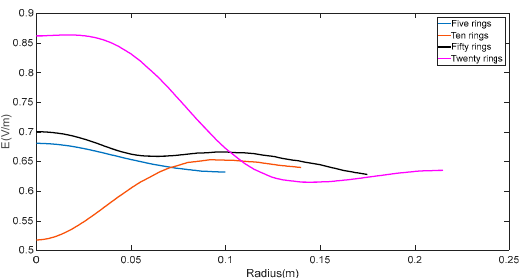
Figure 15. Radial profile of the electric field for a wet poplar sample with a 50% dielectric constant variation between growth rings. Dielectric constant values were used with 0% moisture content according to [27].